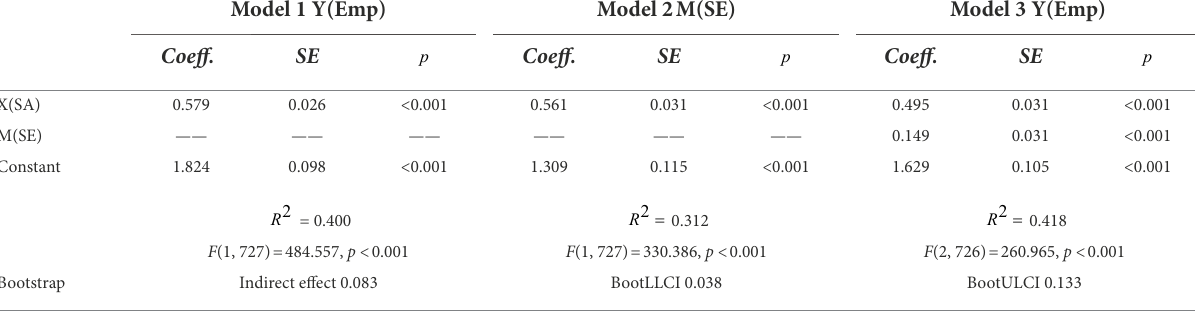
TABLE 7 Mediating effect of social adaptability on employability.